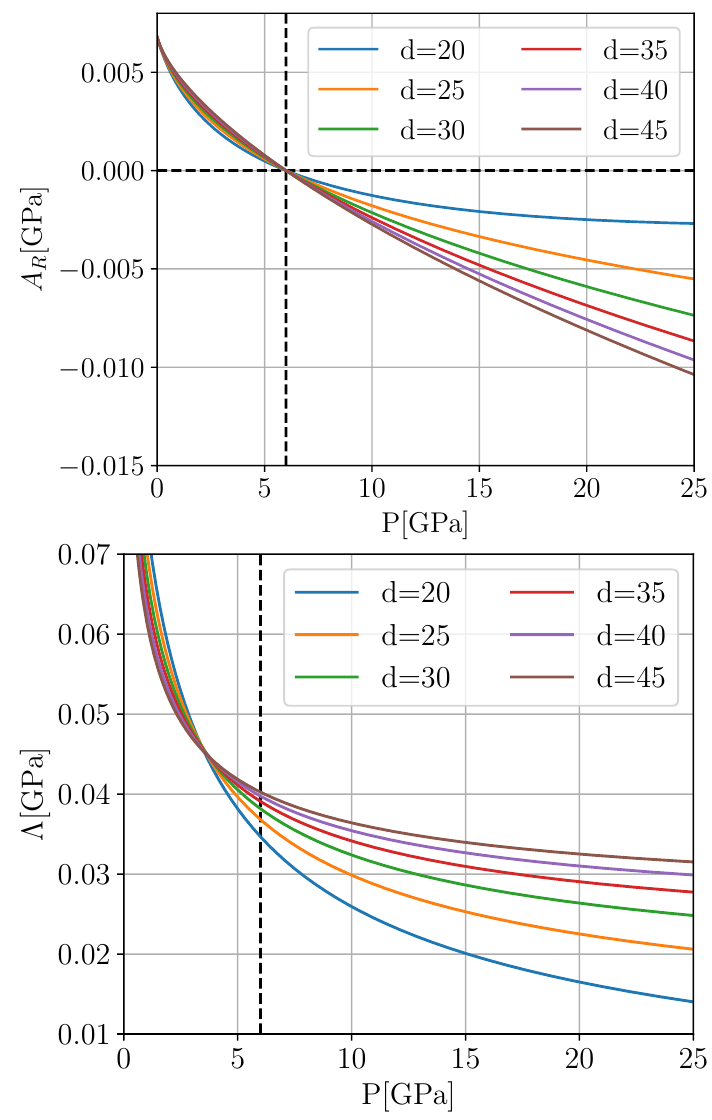
Figure 9. Illustration of the remaining d -dependence of the parametrization of A R ( T R , e ( P )) by Equation (32) (upper panel) and the resulting function Λ ( e ( P )) as given by the Borel transform Equation (37) (lower panel). Parameters b and c were eliminated in favor of parameter λ from ambient pressure LT and a chosen pressure parameter P 0 = 6.0